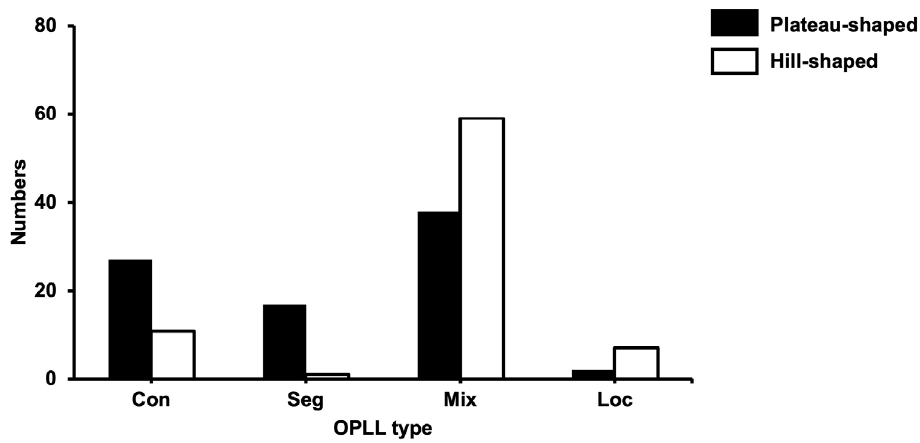
Figure 2. The relationship between OPLL type and OPLL shape. OPLL, ossification of the posterior longitudinal ligament; con, continuous; seg, segmental; mix, mixed; loc, localized.